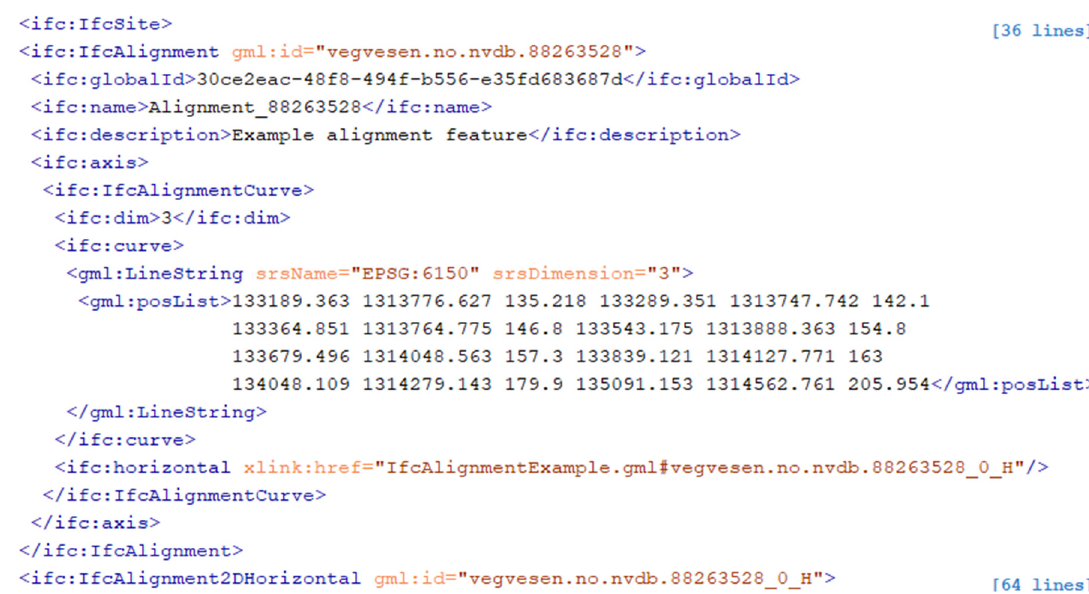
Figure 19. Extract of an example GML file for IFC.